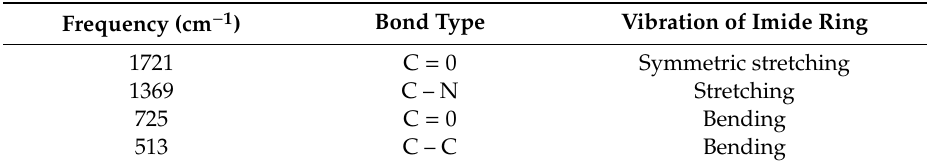
Table 1. Important frequencies of IR absorption.